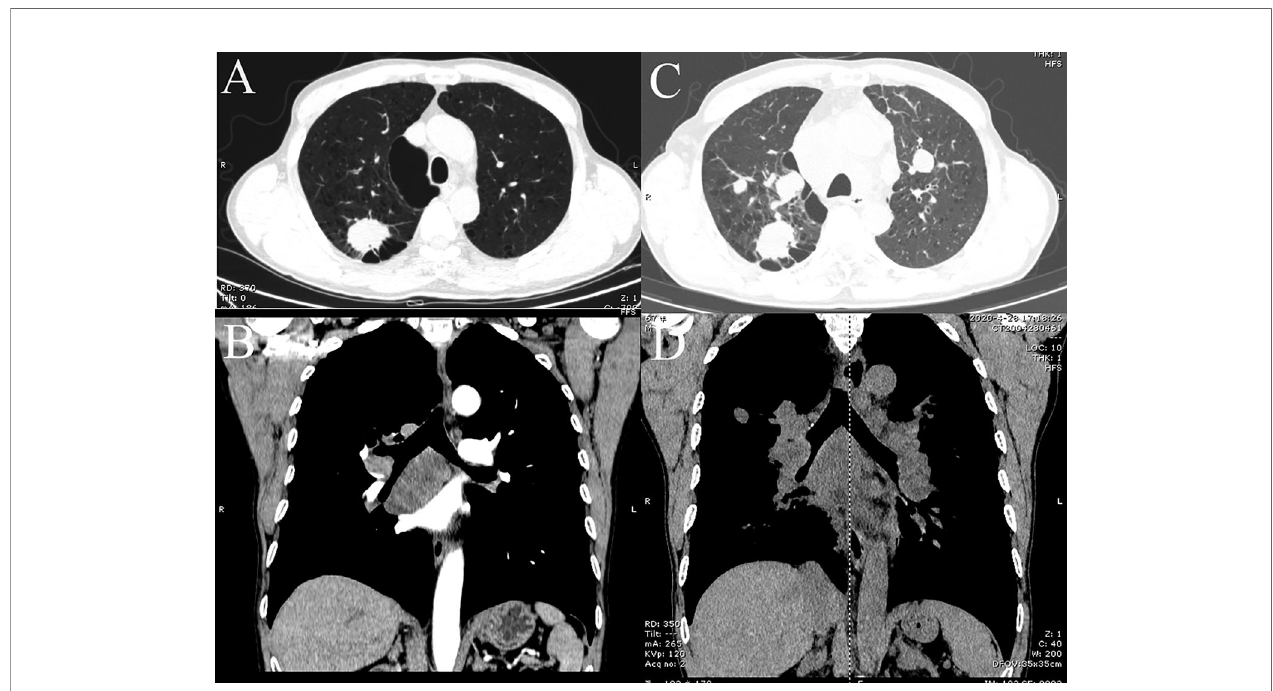
FIGURE 2 | CT images of lung tumor and mediastinal lymph nodes of patient. (A, B) Baseline inspection on April 18, 2019, showed right upper lobe tumor and subcarinal lymph node metastasis, respectively. (C, D) Images on April 6, 2020, suggested multiple pulmonary metastases and multiple mediastinal lymph node metastases,